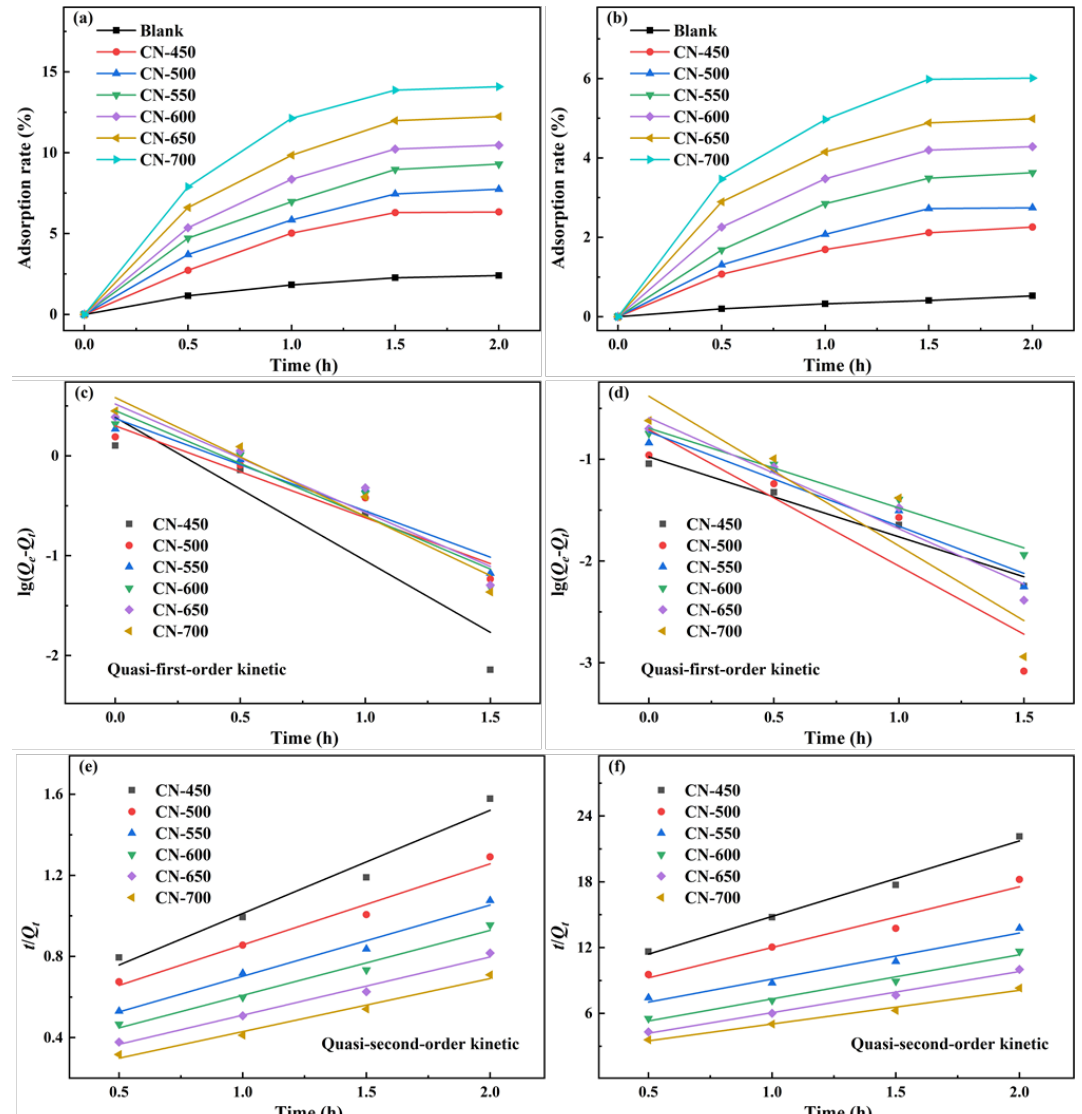
Figure 10. Adsorption efficiencies of RhB ( a ) and MO ( b ) in the dark condition; corresponding adsorption kinetic curves for RhB ( c , e ) and MO ( d , f ) for all samples.